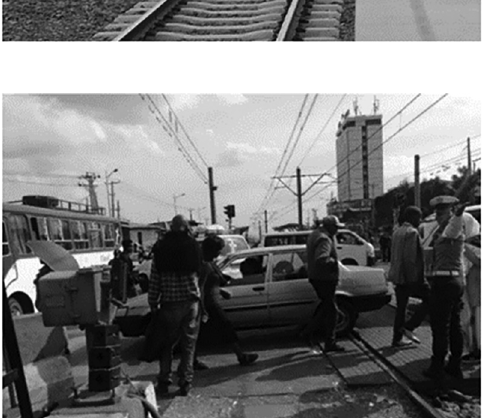
Figure 1. Pedestrians crossing